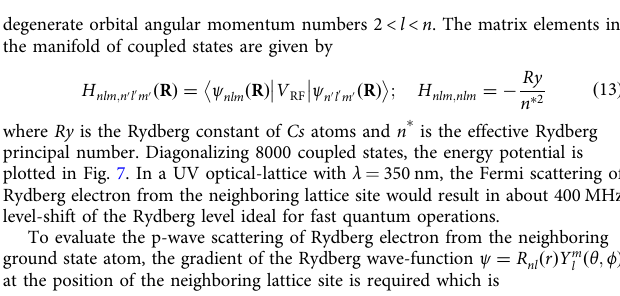
(cid:1) (cid:3) (cid:1) central qubits would be compensated